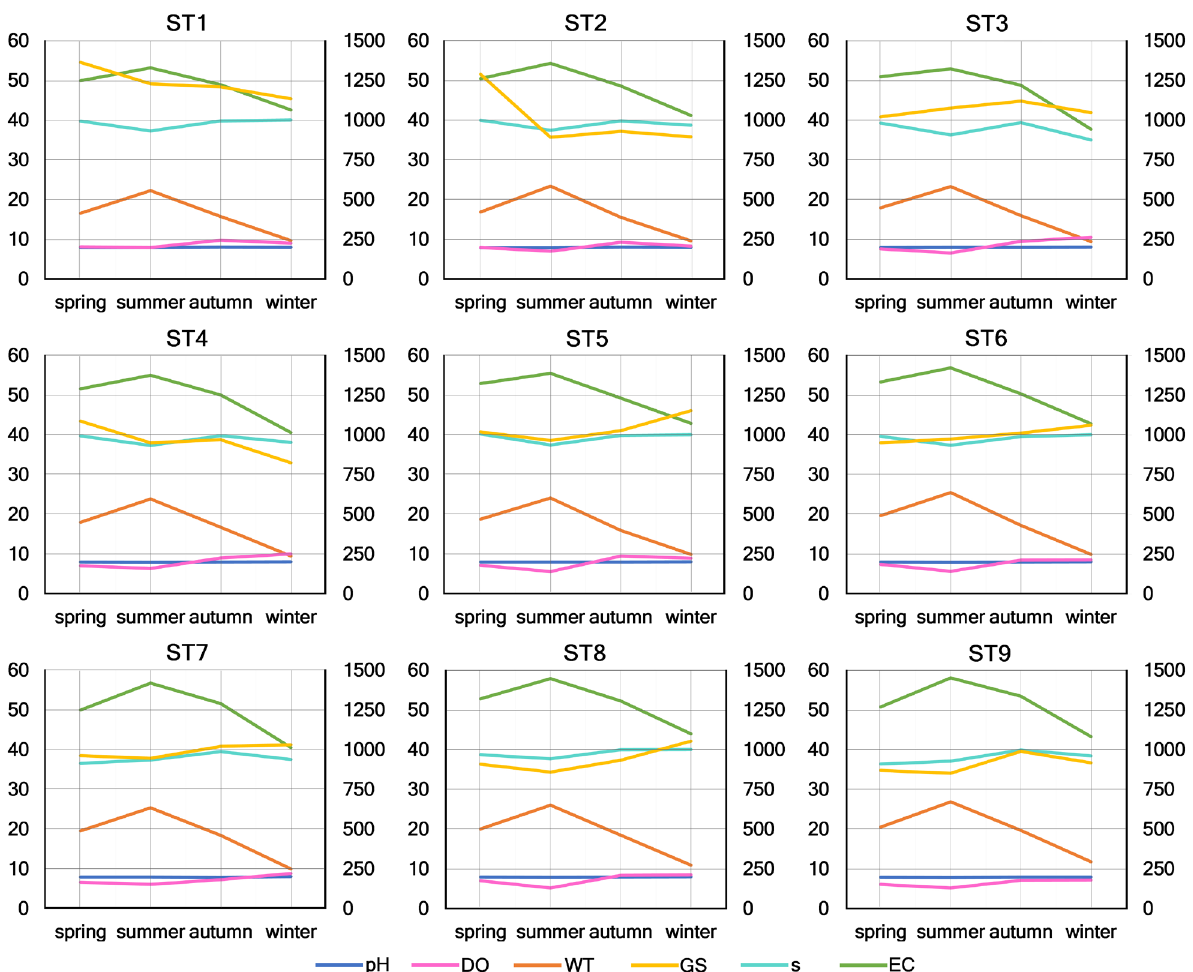
Figure 3. The seasonal variations in the environmental factors according to the stations (scale on the right axes for